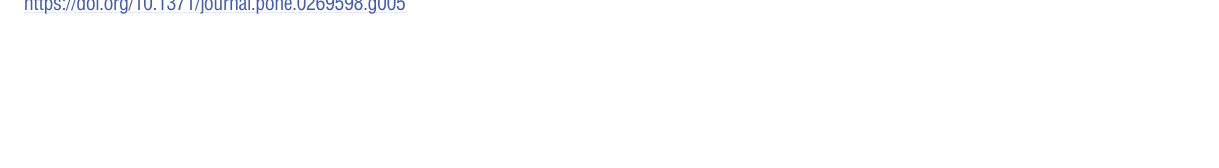
Fig 5. The inferred latent ideology processes ~ p processes ~ p ð t Þ are shown in black and the observed (smoothed) processes ^ p i